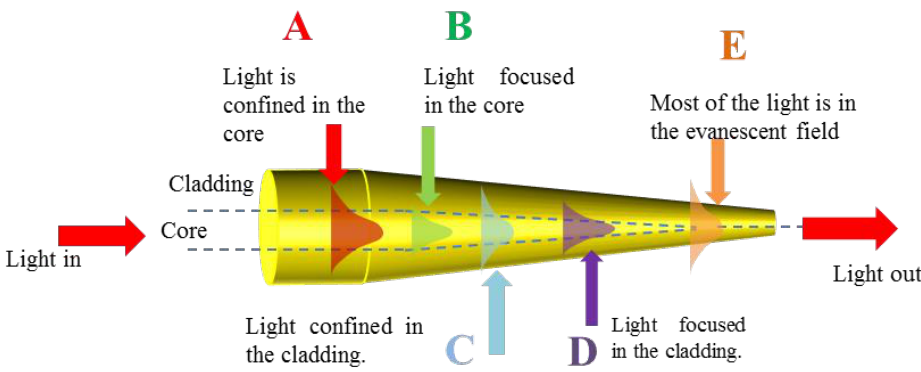
Figure 4. Modes evolution along the length of the tapered optical fiber.